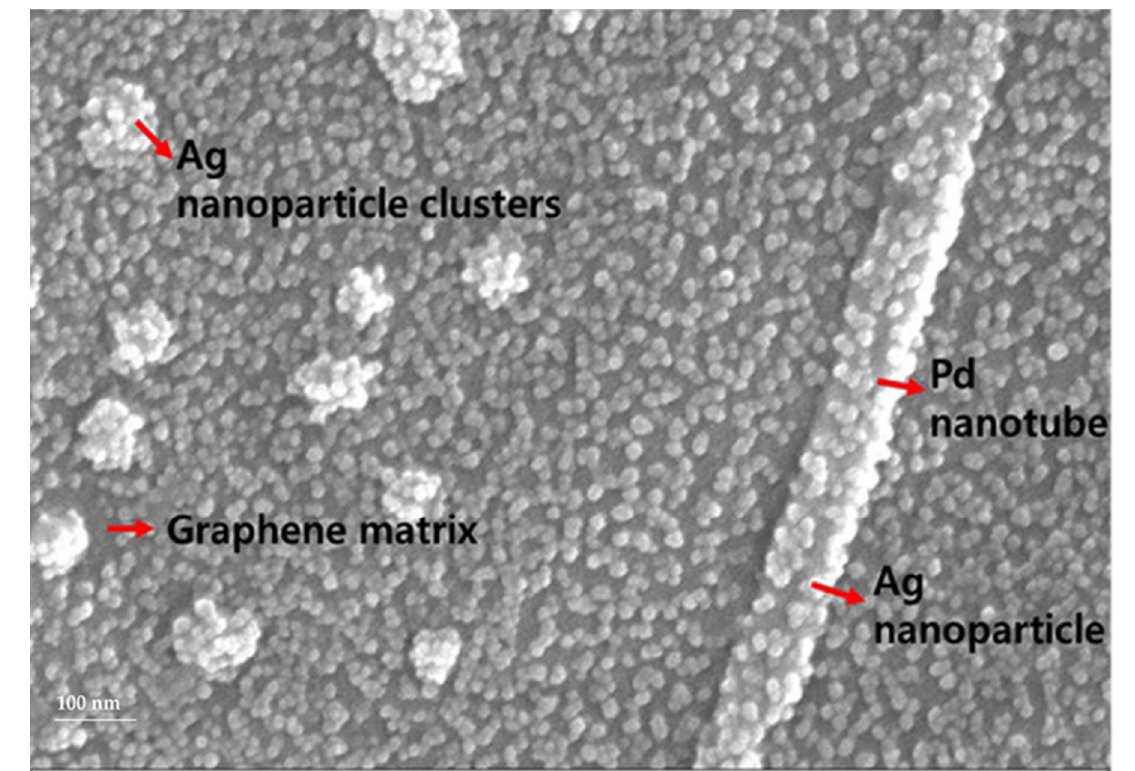
Figure 12. SEM image of graphene–Pd–Ag on sensing FETs [165] (CC BY).